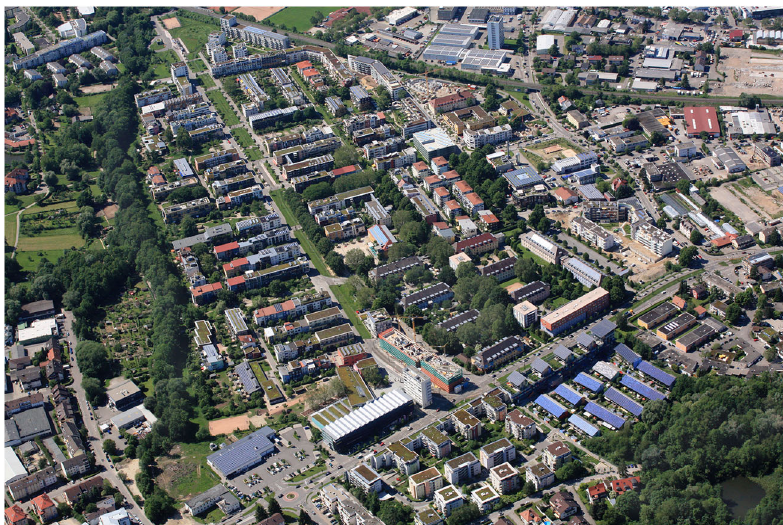
Fig. 5 Aerial view of Vauban neighbourhood in Freiburg, Germany. Copyright permission by Erich Meyer, Hasel|Stadt Freiburg